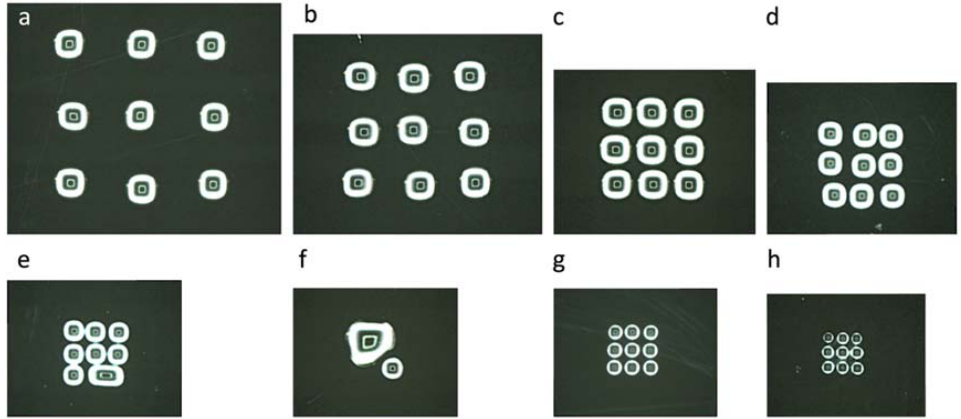
Figure 2. Optimization of the printing on a glass substrate. Water droplets were piezo dispensed (pulse duration of 15 μ s and voltage of 75 V) as a 3 × 3 array on a glass coverslip: (a) 100 droplets at a